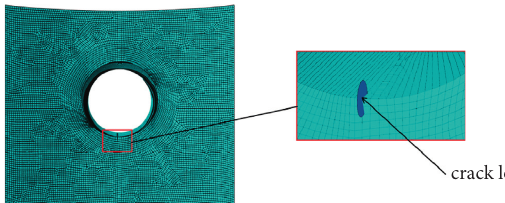
Figure 9: RPV submodel with postulated crack in Abaqus.